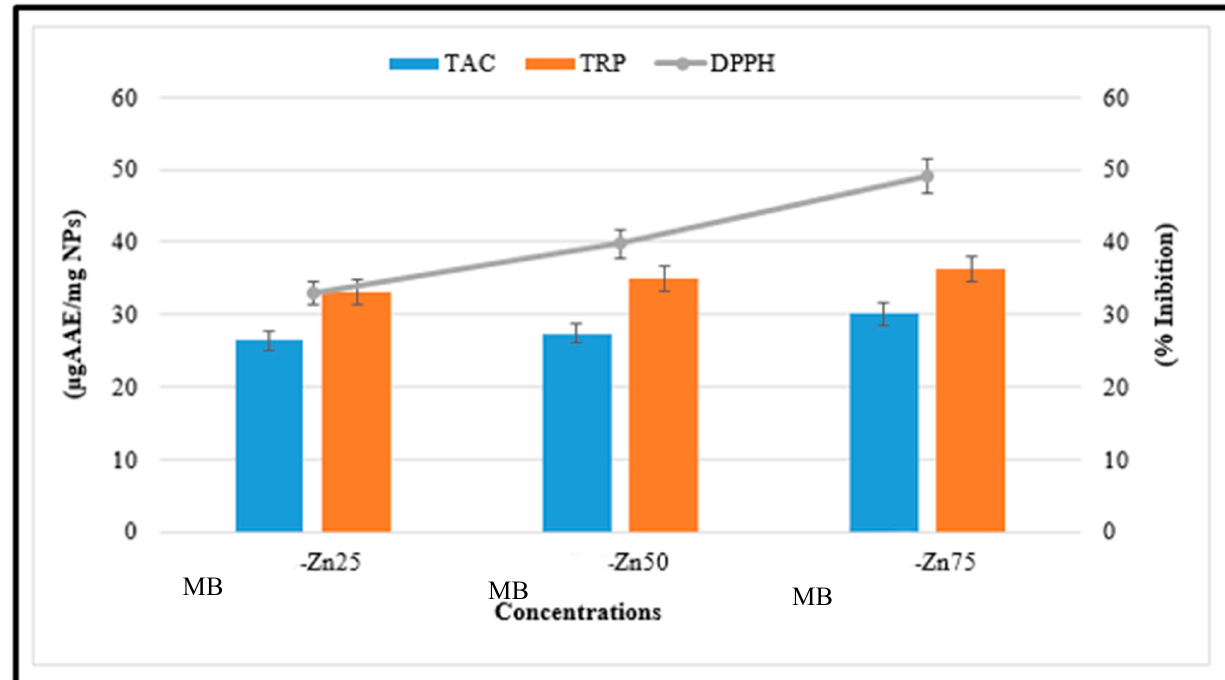
Figure 7. Antioxidant potential of MB-ZnO.